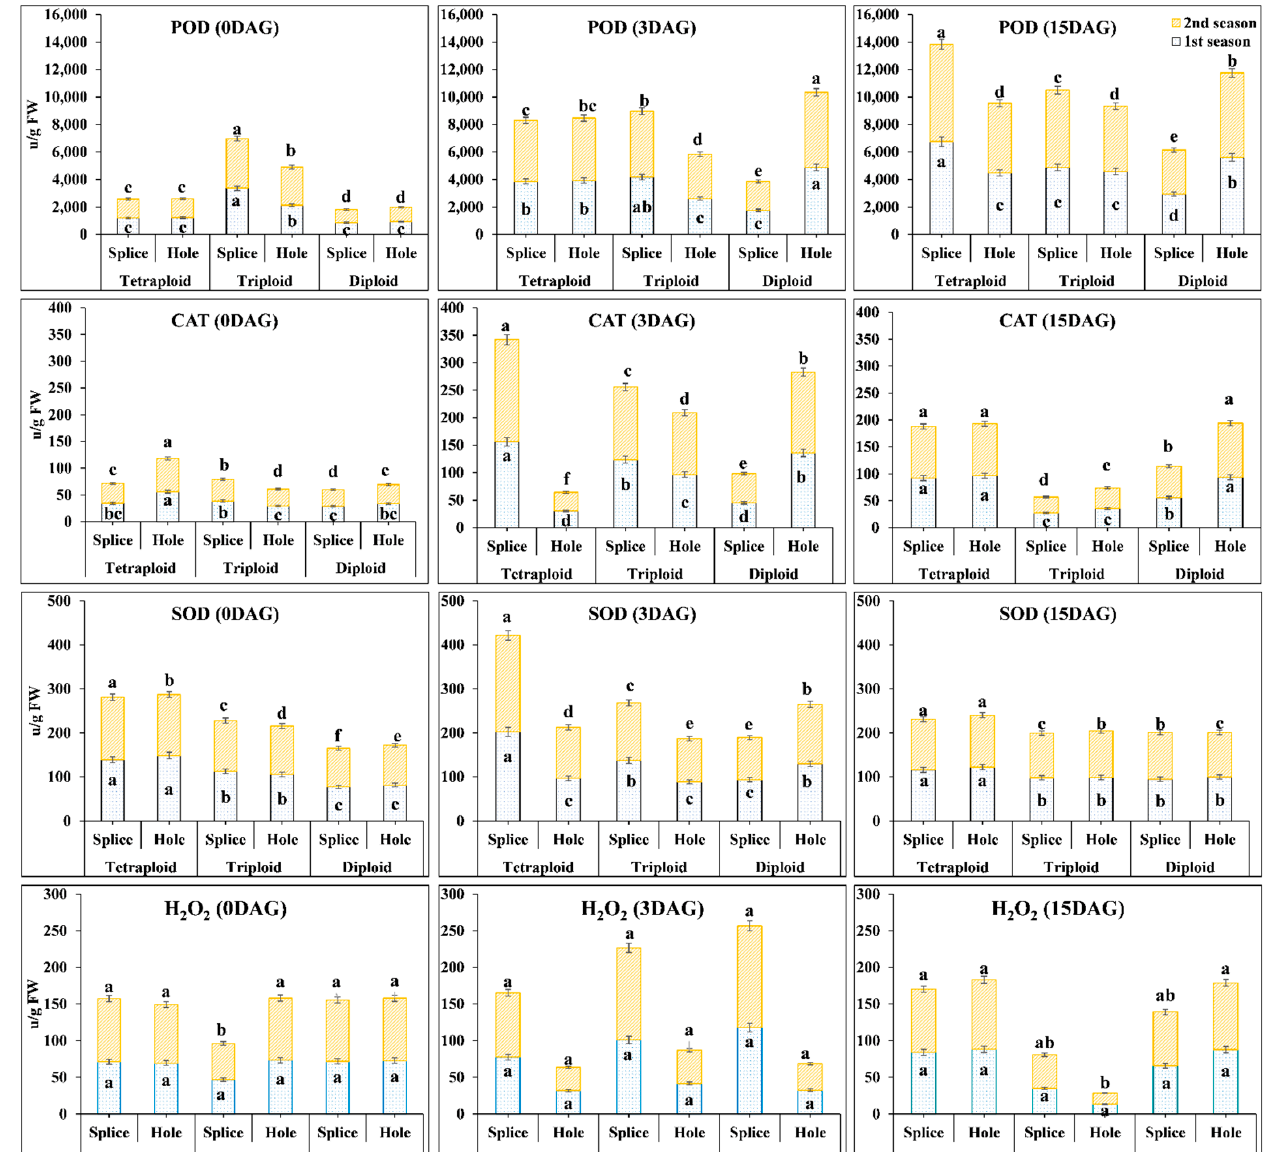
Figure 4. Peroxidase (POD), Superoxide dismutase (SOD), Catalase (CAT), and Hydrogen peroxide (H 2 O 2 ) contents in different ploidy watermelons grafted with splice and hole methods at 0, 3, and 15 DAG during March and August 2019 cropping seasons. The bars with different letters differ significantly ( p < 0.05). DAG: Days after grafting. 3.4. Carbohydrates (Starch and Sugars) Contents in the Grafting Union among Di, Tri, and Tetraploid Watermelon with Different Grafting Methods at Different Days after Grafting Generally, carbohydrates provide energy in the plant. The cotyledons are the source of carbohydrates in the seedlings; the survival rate was positively correlated with increased starch content during the grafting process. The sugars results (Figure 5) showed